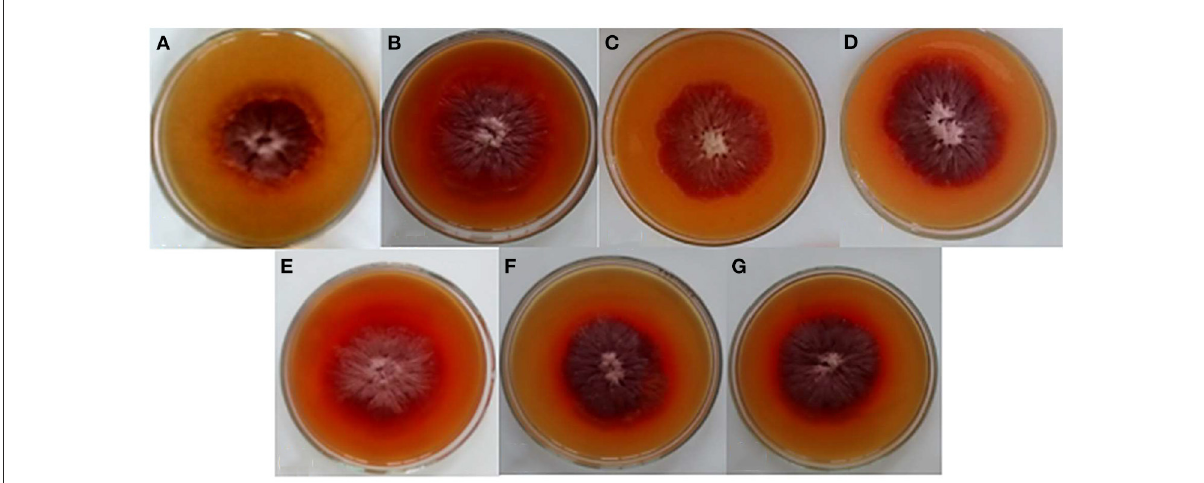
FIGURE2 Visual aspect of the colonies of Monascus ruber CCT 3802 grown in different concentrations of maltose syrup. (A) MEA; (B) 1.0g L − 1 of maltose syrup; (C) 2.5g L − 1 of maltose syrup; (D) 5.0g L − 1 maltose syrup; (E) 10.0g L − 1 of maltose syrup; (F) 20.0g L − 1 of maltose syrup and (G) 40.0g L − 1 of maltose syrup.